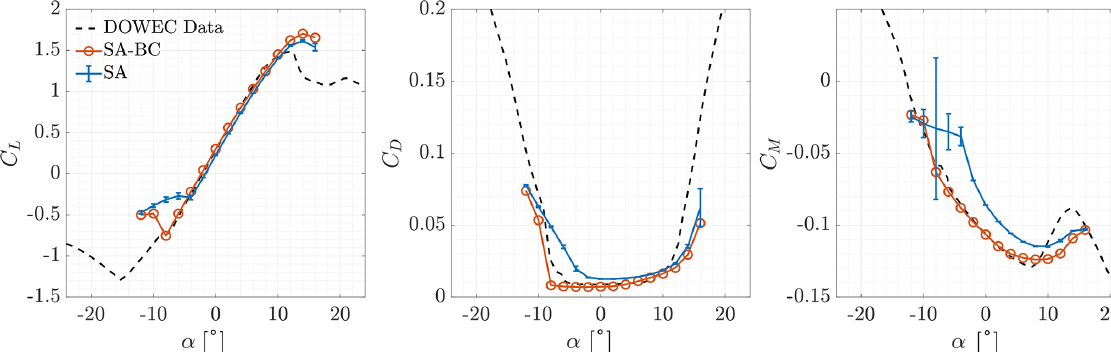
Figure 8. Aerodynamic coefficients of the DU30 airfoil.